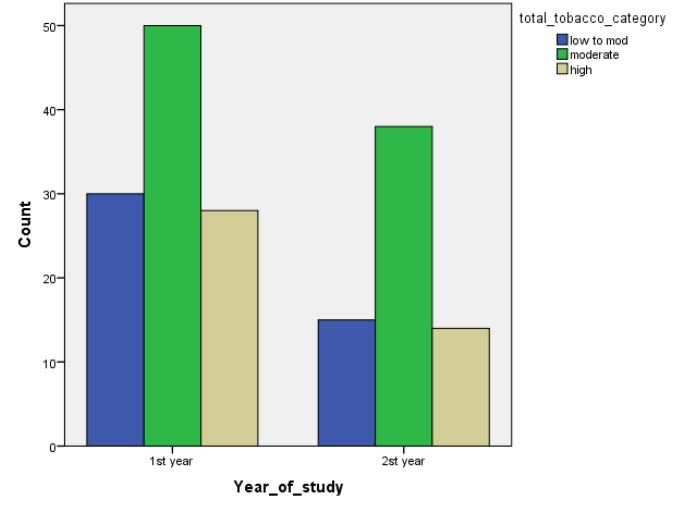
Figure 5. Frequency of tobacco and alcohol consumption depending on year of study